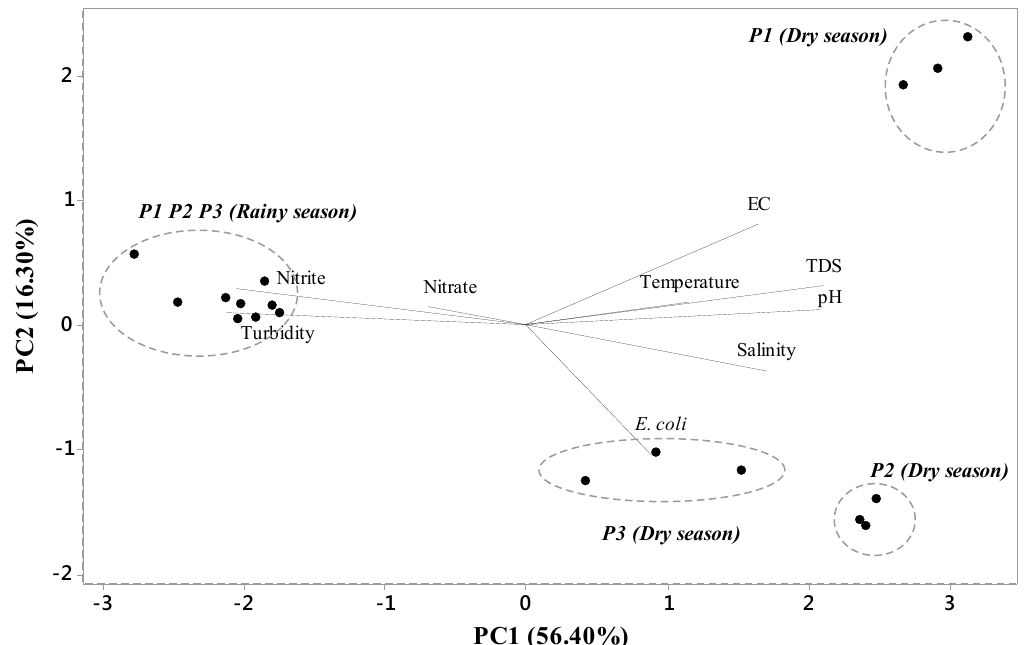
Figure 4. Loading and score plots to the all variables and season studied. EC (electrical conductivity), TDS (total dissolved solids), E. coli ( Escherichia coli ). P1, P2 and P3 (collection points). Table 3. Loadings of the variables for the first three principal components.